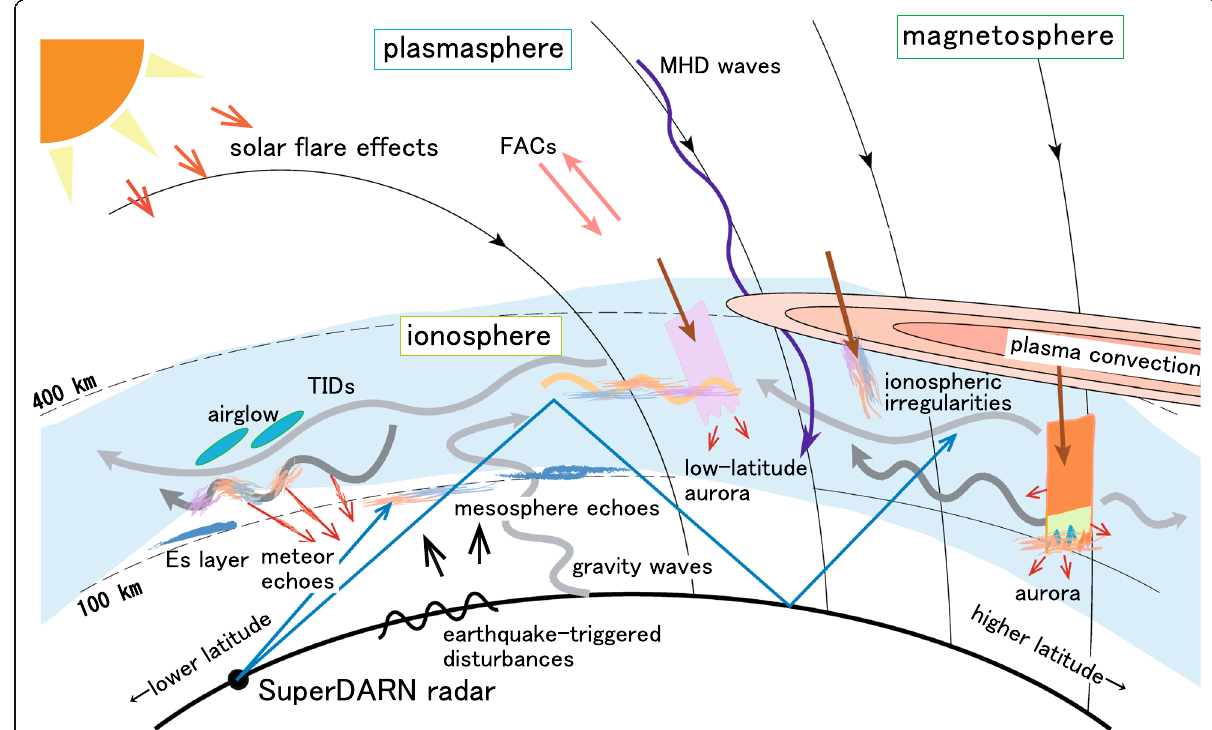
Fig. 7 Schematic illustration of natural phenomena which can be studied by SuperDARN